Question: Summarize what this figure shows in one sentence.
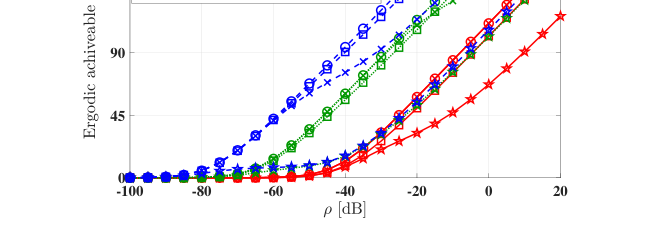
Answer: Simulation results of the ergodic achievable sum-rate R versus the transmit power ρ for different wavelength λ and different number of RHS elements N, with the number of UEs K = 8.